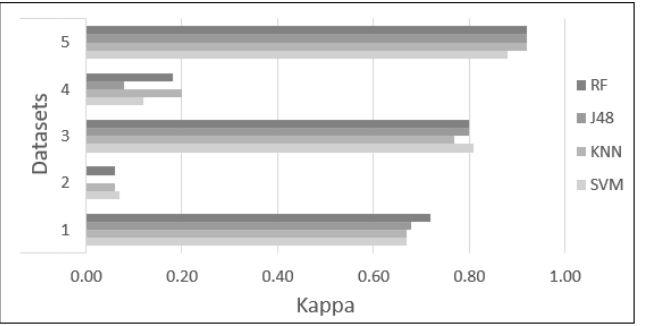
Figure 9. Difference in Kappa values among the different classification methods.